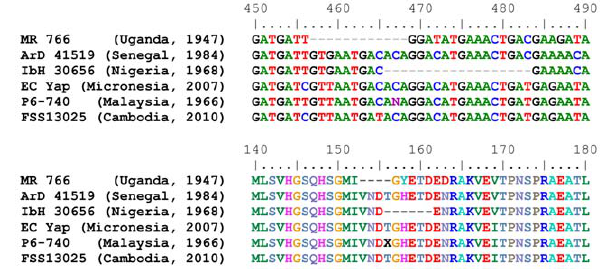
Figure 2. Zika virus phylogeny. Nucleotide (top) and amino acid (bottom) sequences of the envelope protein/gene of Zika virus strains showing the deletions in the potential glycosylation sites of the MR 766 (Uganda, 1947) and the IbH 30656 (Nigeria, 1968) strains. Deletions are indicated by dashes. The ‘‘N’’ at position 467 of the P6-740 strain (Malaysia, 1966) represents an equally weighted double population of the nucleotides ‘‘C’’ and ‘‘T’’. This translates to an ‘‘X’’ at position 165 of the amino acid alignment.